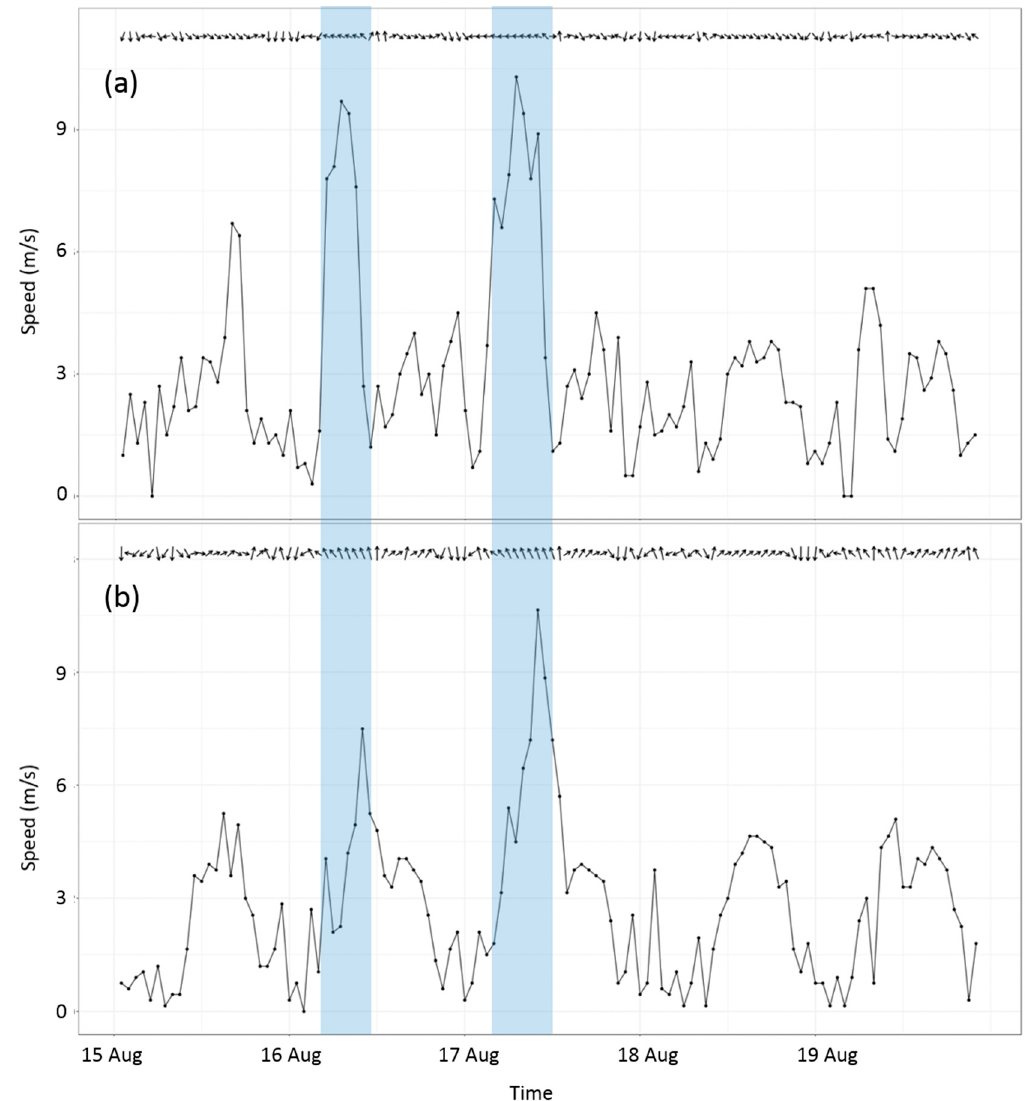
Figure 4. The 10-min average winds observed at the top of each hour at sensor: ( a ) NM1; and ( b ) NM3. The blue shading highlights two gap wind events.